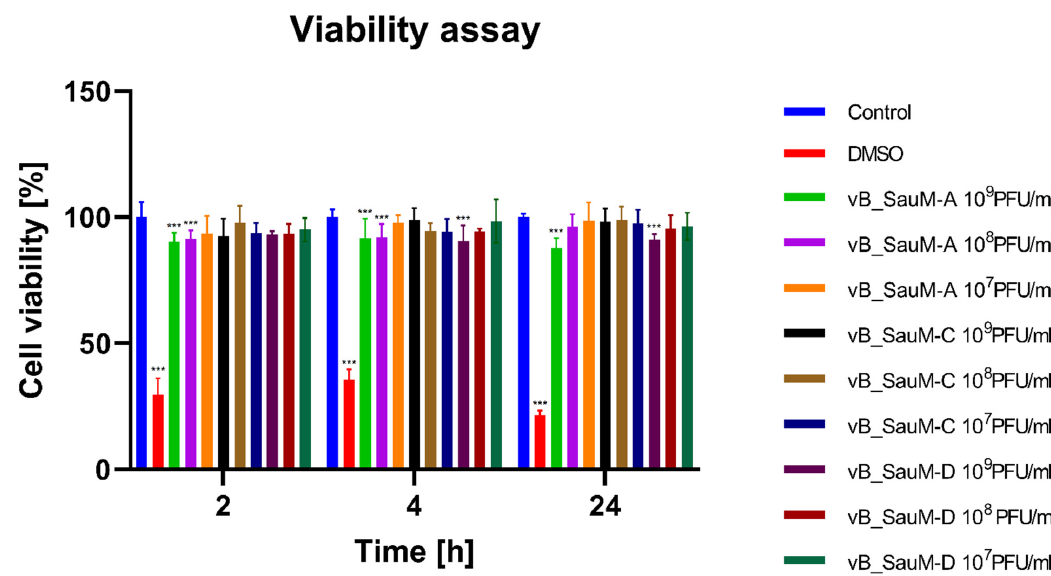
Figure 1. Cell viability of the BJ cells treated with phages vB_SauM-A, vB_SauM-C and vB_SauM-D at different concentrations after 2, 4 and 24 h of incubation in comparison to the untreated negative control (blue) and 10% DMSO-treated positive control (red). Mean values from three independent experiments are shown, with error bars representing SD. Statistical analysis was performed using the Kruskal–Wallis test followed by Dunn’s multiple comparison test for values with nonparametric distribution, with *** p < 0.001.